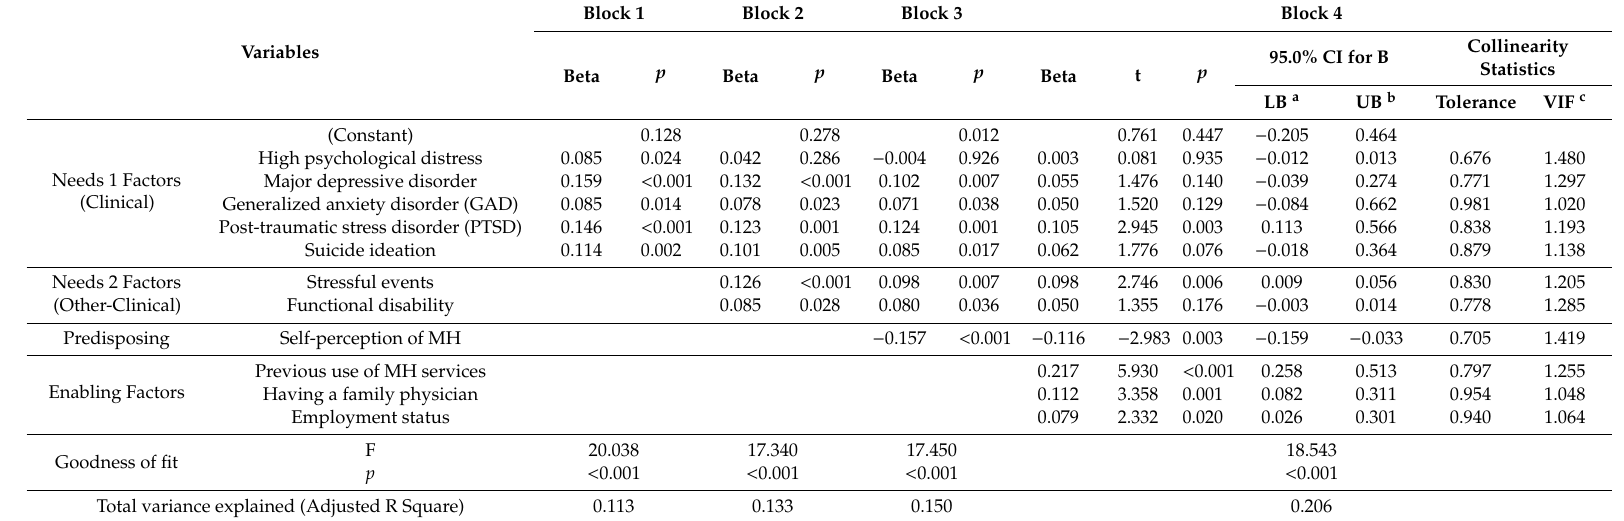
Table 3. Predictors of number of types of healthcare professionals consulted for mental health (MH) reasons (N = 746): Multiple linear regression model.